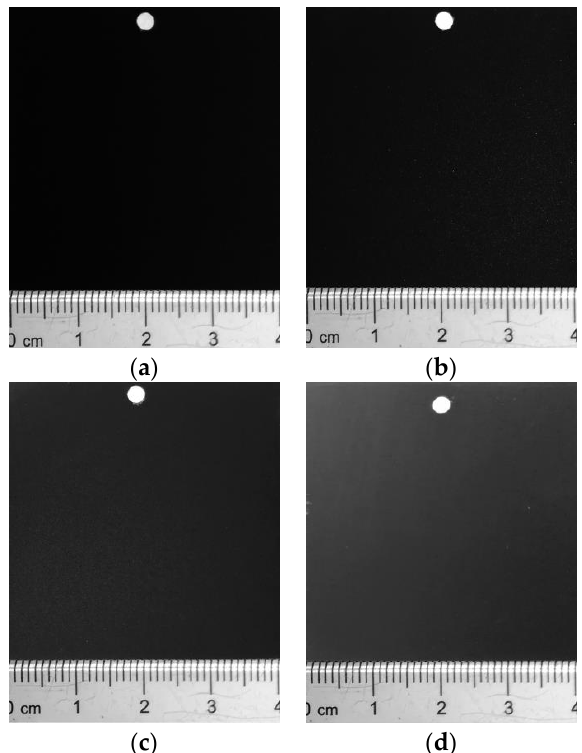
Table 5. Thickness of the coating.